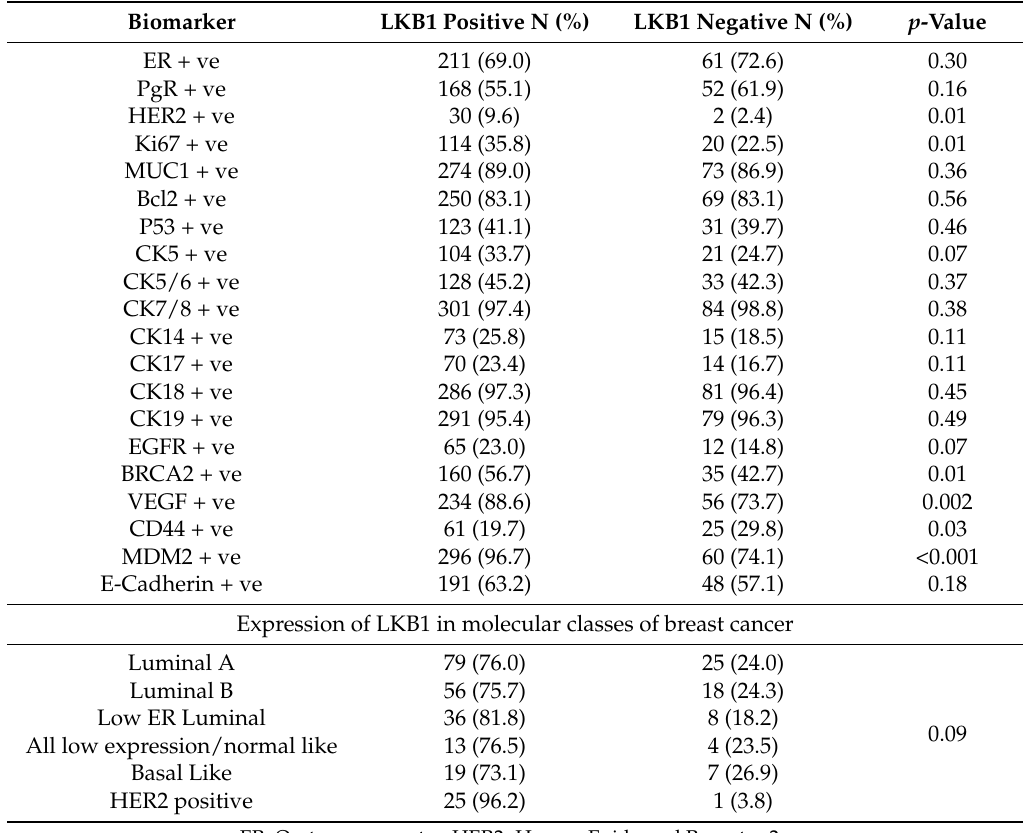
Table 1. Intracellular relationships between LKB1 with biological markers in older women with early operable primary breast